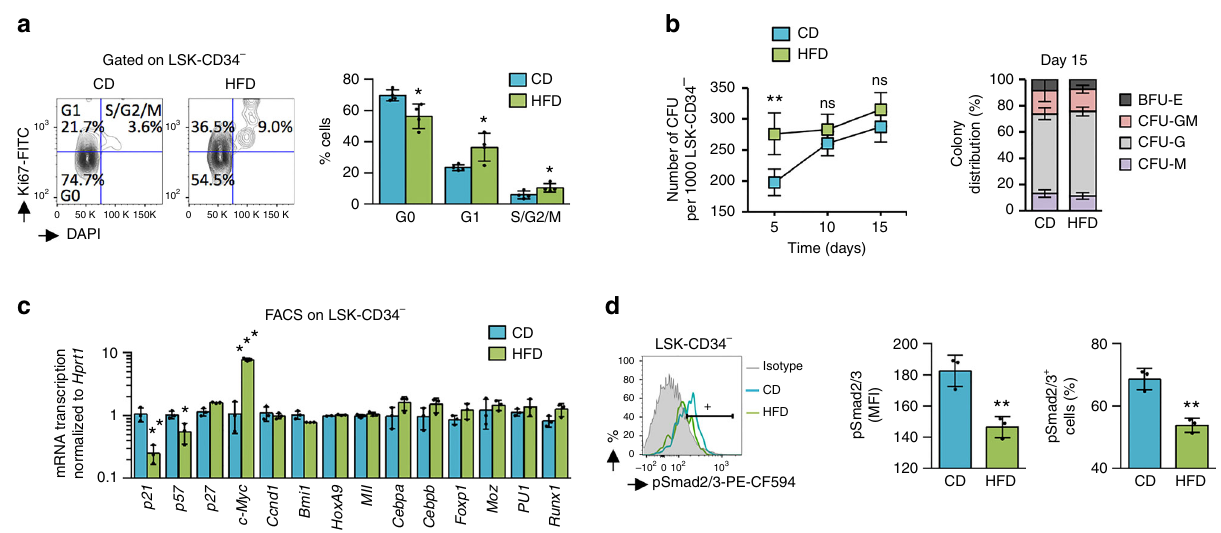
Fig. 5 Short-term HFD affects the TGF- β mediated quiescence of HSC. a HFD affects quiescence of LSK-CD34 − HSC, as assessed by the reduced proportion of cells in G0, n = 4 mice per diet group. b HFD HSC show quick cell forming unit (CFU)-colony formation on semisolid medium, which indicated that HFD HSC have left the dormant state and are going into differentiation more rapidly, n = 4 mice per diet group. As assessed on semisolid medium at day 15, no difference is observed among CFU; erythrocyte (E), granulocyte-monocyte (GM), granulocyte (G), and macrophage (M). c Target genes, known to be activated by TGF- β , such as the Cyclin-dependent kinase inhibitor p21 Cip1 and p57 Kip2 are downregulated in LSK-CD34 − cells following a HFD. Furthermore, transcription of the c-Myc gene, repressed by TGF- β , is activated in HSC from HFD-fed mice, n = 3 mice per diet group. d HFD affects phosphorylation of pSmad2/3 in LSK-CD34 − HSC. The pSmad2/3 is detected by fl ow cytometry and results show its expression (MFI; median fl uorescence intensity) and proportion (%) of pSmad2/3 + cells among LSK-CD34 − HSC, n = 3 mice per diet group. Data show mean ± SD; ns, non- signi fi cant ( P > 0.05); * P < 0.05; ** P < 0.01; *** P < 0.001 (two-tailed unpaired Student ’ s t